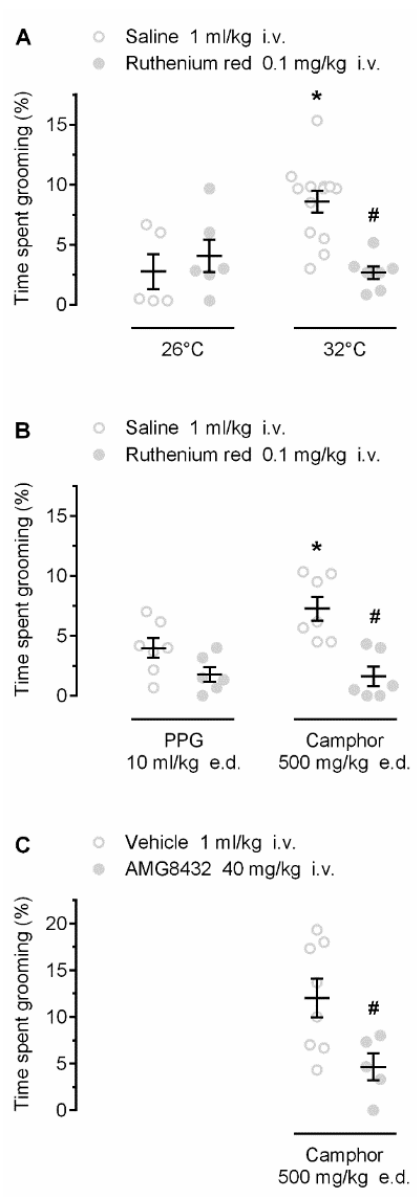
Figure 3. Effects of pharmacological blockade of TRP channels on warmth- ( A ) and camphor- ( B and C ) induced grooming. Warmth- and camphor-induced self-grooming responses were blocked by pretreatment with the nonselective TRP antagonist ruthenium red (dose indicated). Camphor-induced self-grooming was also blocked by AMG8432, a relatively nonselective TRPV3 antagonist. Both ruthenium red and AMG8432 were injected 30 min prior the exposure to 26 °C or 32 °C, or the camphor or PPG administration. An asterisk (*) indicates a significant difference ( p < 0.05) between grooming responses at 32 vs. 26 °C ( A ), or in saline-pretreated camphor-treated vs. saline-pretreated PPG-treated rats ( B ). A pound sign (#) indicates a significant difference ( p < 0.05) between grooming responses: in ruthenium red- vs. saline-pretreated rats at 32 °C ( A ); ruthenium red- vs. saline-pretreated camphor-treated rats ( B ); or in AMG8432-pretreated camphor-treated vs. vehicle-pretreated camphor-treated rats ( C ).